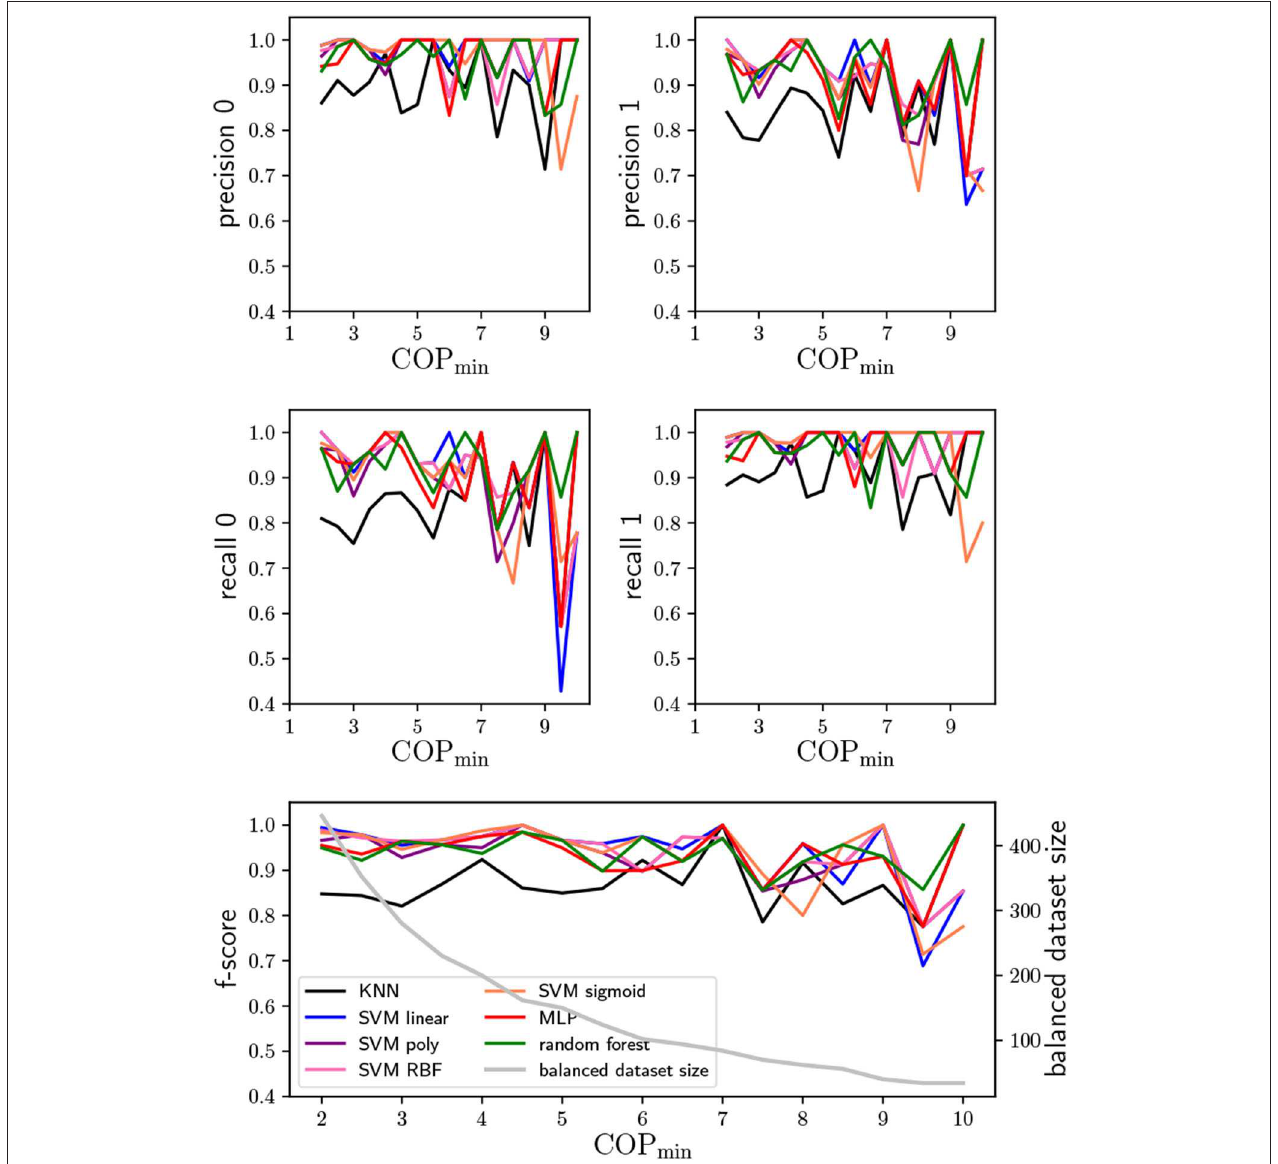
FIGURE 7 | Precision and recall of the COP span from 2 to 10, for the two possibilities of the G variable (0 and 1), and the respective f-score average. In the f-score plot it is also shown the balanced dataset